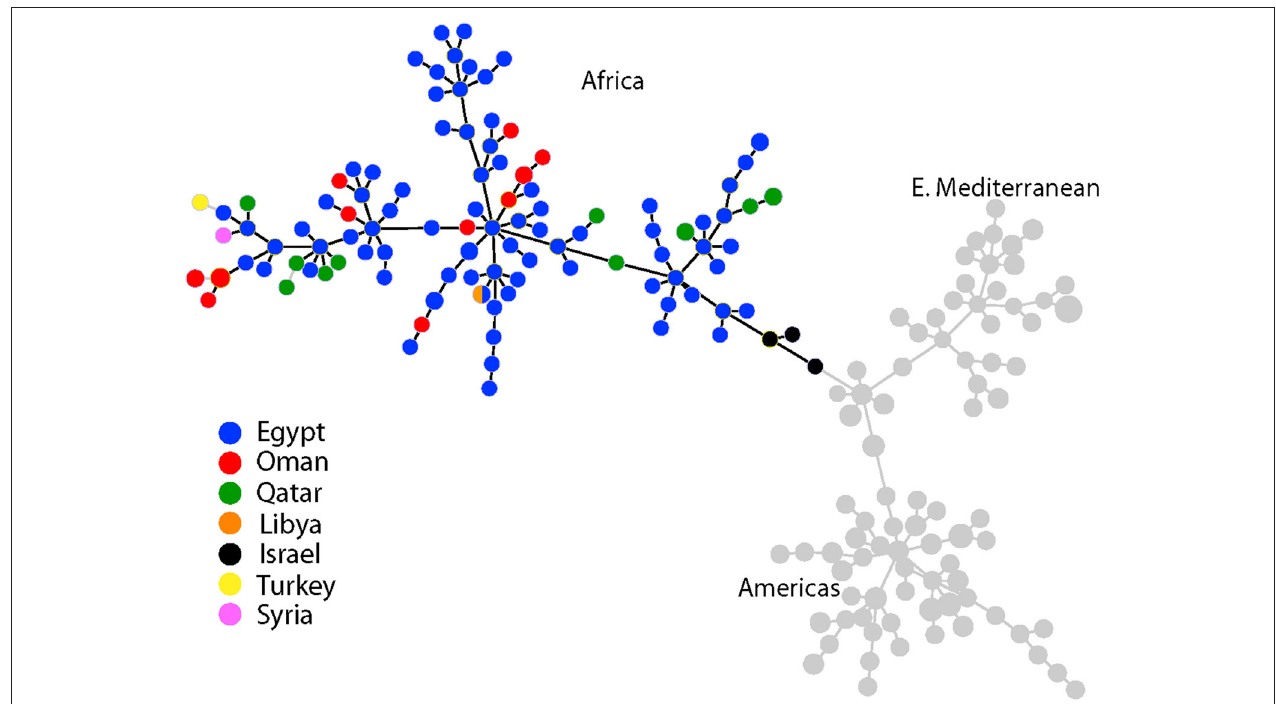
FIGURE 2 | Minimum spanning tree of 221 Brucella melitensis isolates based on MLVA-10 genotyping. Country of origin for isolates from the Middle East is represented by the colored circles. Additional isolate details are found in Table 3 .